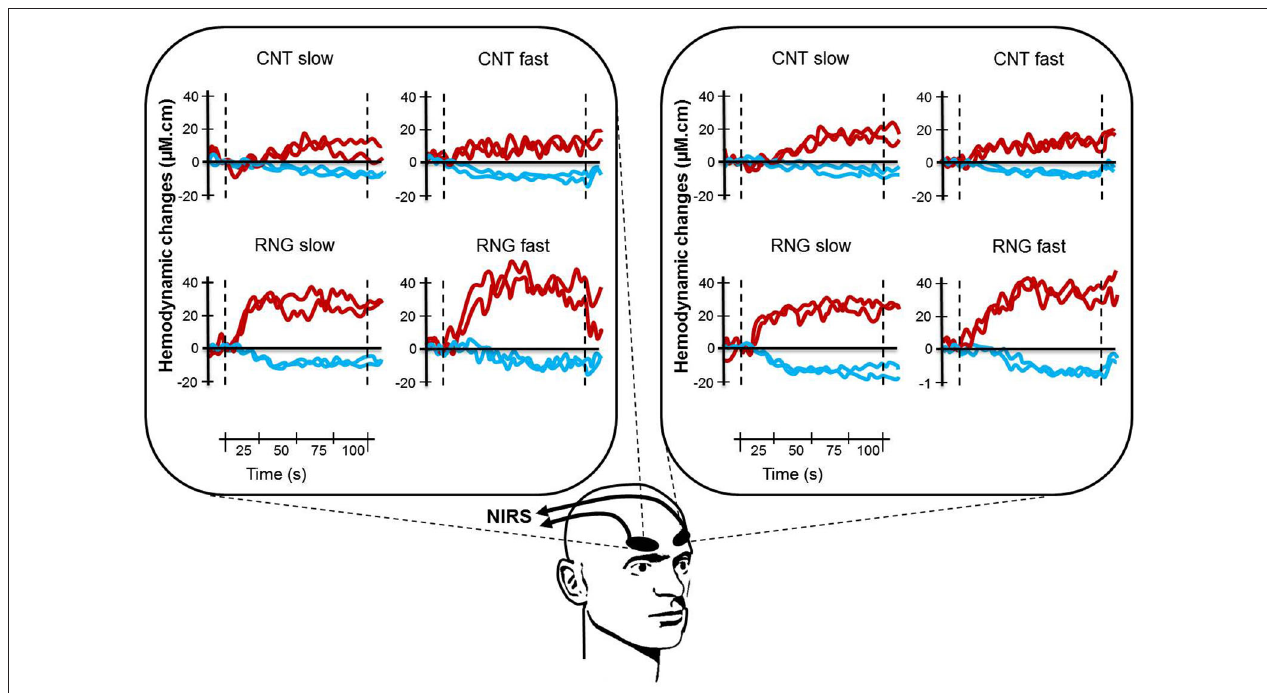
FIGURE 3 | Illustration of typical cortical activation patterns for one subject as a function of task (CNT task, upper side vs. RNG task, lower side), trial and pace (slow vs. fast) for both hemispheres (right DLPFC,